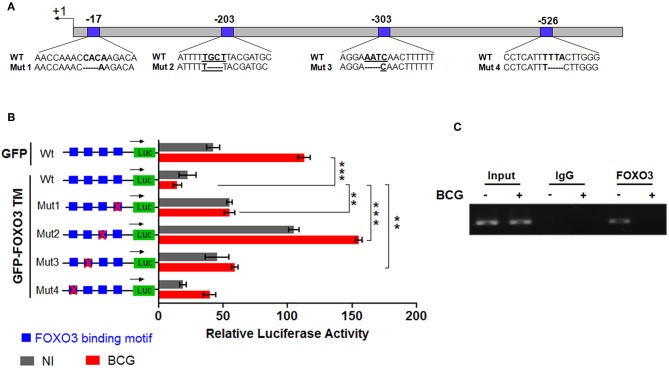
FOXO3 binds to IL-10 promoter, inhibiting its transcriptional activity in BCG-infected cells. In order to determine the contribution of each Forkhead DNA-binding element identified in silico, four mutants of IL-10 promoter were generated as indicated in (A). (B) representation of gene reporter assay performed on the wild type IL-10 promoter and the four mutants (Mut1, Mut2, Mut3, Mut4). RAW 264.7 macrophages were transfected with the indicated constructs. Twenty-four hours later, cells were infected or not with BCG and luciferase activity was measured 6 h later in GFP positive alive cells. The data correspond to the mean ± SEM of three different experiments conducted in triplicates. Asterisks indicate statistical significance (n = 3, ** p < 0.01, *** p < 001). (C) TDMs were infected with BCG for 3 h and treated with Wort for additional 2 h. Next, CHIP assay was conducted to verify FOXO3 recruitment to the site −203 of the IL-10 promoter with either anti-FOXO3 Ab (lane 1 and 2) or anti-IgG isotype Ab (lane 3 and 4). Total input of BCG infected and non-infected cells are shown in lanes 5 and 6.